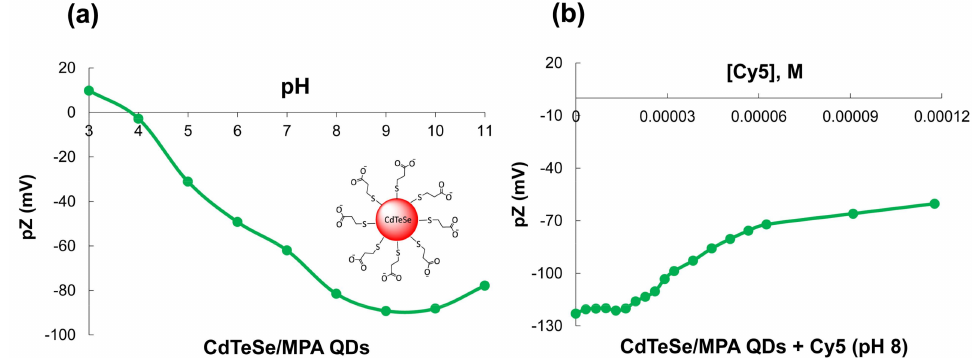
Figure 6. ( a ) Potential Z of the MPA-CdTeSe QDs at different pH values and ( b ) the titration of the MPA-CdTeSe QDs with the Cy5 at pH